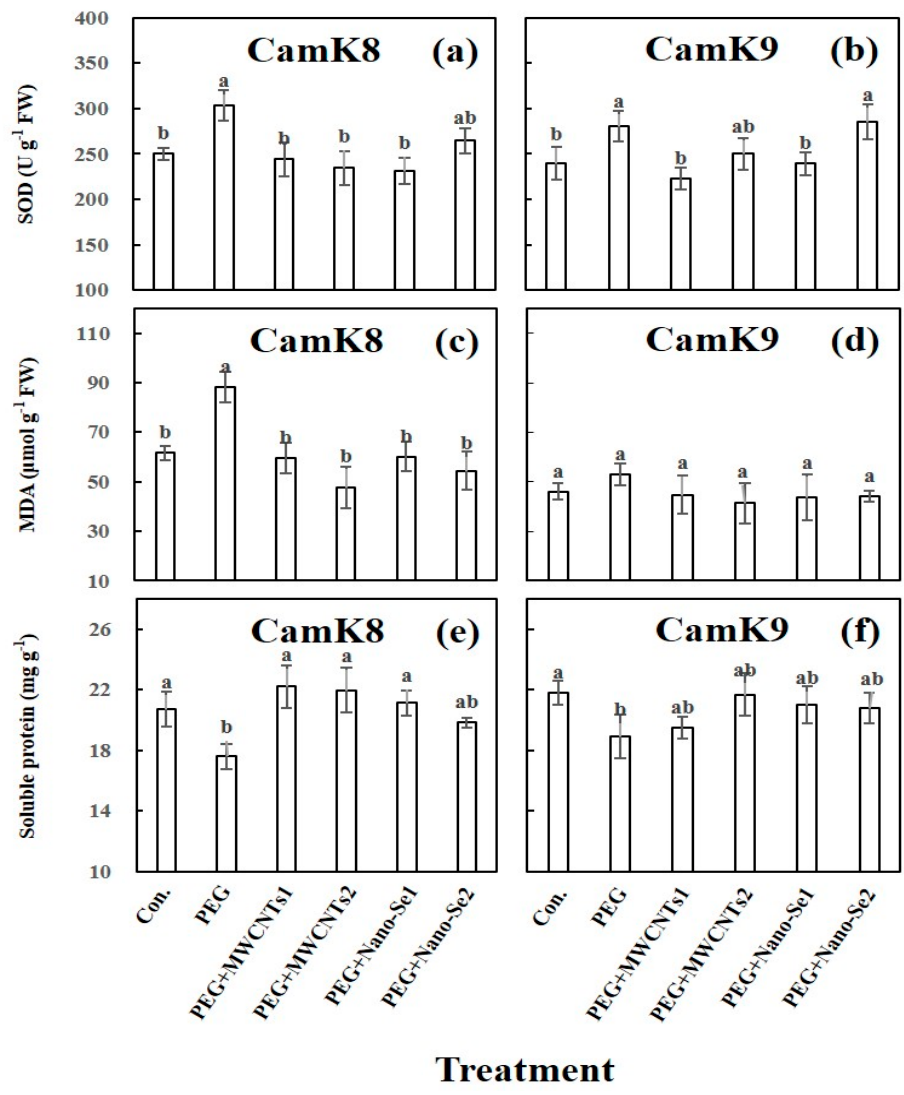
Figure 3. Effect of various treatments on SOD (U g − 1 ) ( a , b ), MDA ( µ mol g − 1 ) ( c , d ) concentration, and soluble protein (mg g − 1 ) ( e , f ) of CamK8 ( a , c , e ) and CamK9 ( b , d , f ) under PEG-induced WDS at the third day after treatment. Con.: untreated control; PEG + MWCNTs 1 or 2: foliar application of MWCNTs with dose 1 (50 mg L − 1 ) or 2 (100 mg L − 1 ) following root application of PEG solution concentration (19.0 mM); PEG + nano-Se 1 or 2: foliar application of nano-Se with dose 1 (5 mg L − 1 ) or 2 (10 mg L − 1 ) following root application of PEG solution concentration (19.0 mM). Values are means ( n = 3) and bars denote the standard error of the mean. Different letters represent the significant di ff erent values determined by the Tukey post hoc test ( p ≤ 0.05).